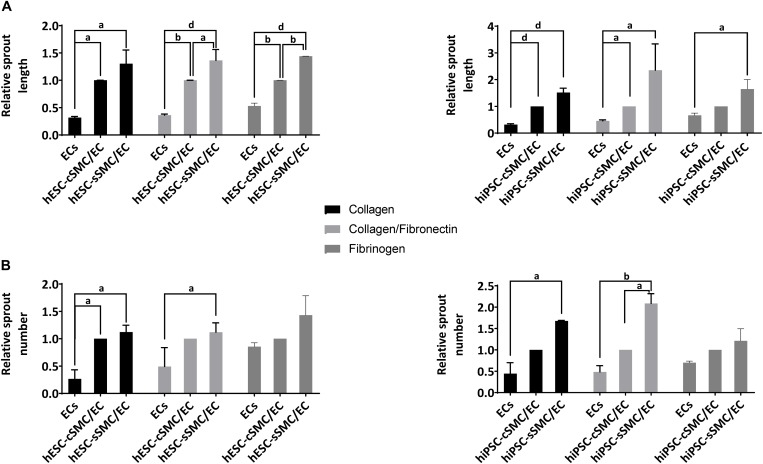
Functional characterization of vascular organoids on hydrogels composed of defined ECM components. hPSC-SMC subtype/EC vascular organoids were added on hydrogels composed of collagen, collagen/fibronectin or fibrinogen and allowed to develop sprouts for 24 h. Length and number of sprouts were quantified using imageJ software. (A) Relative sprout length and (B) relative number of sprouts between EC spheroids and hPSC-cSMC/EC, hPSC-sSMC/EC vascular organoids from three independent experiments are presented in the charts. aP < 0.05, bP < 0.01, dP < 0.0001.